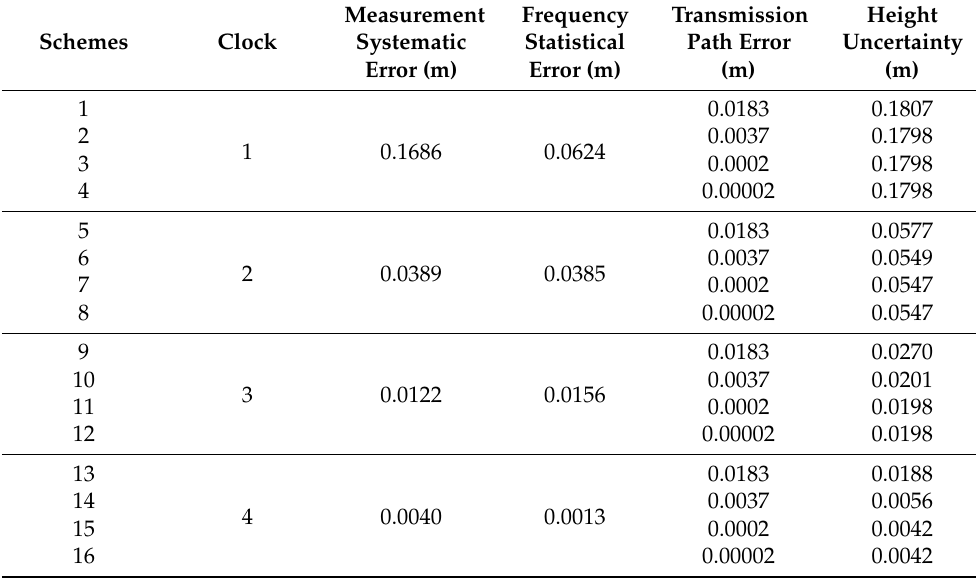
Table 5. Height uncertainty under different schemes of chronometric